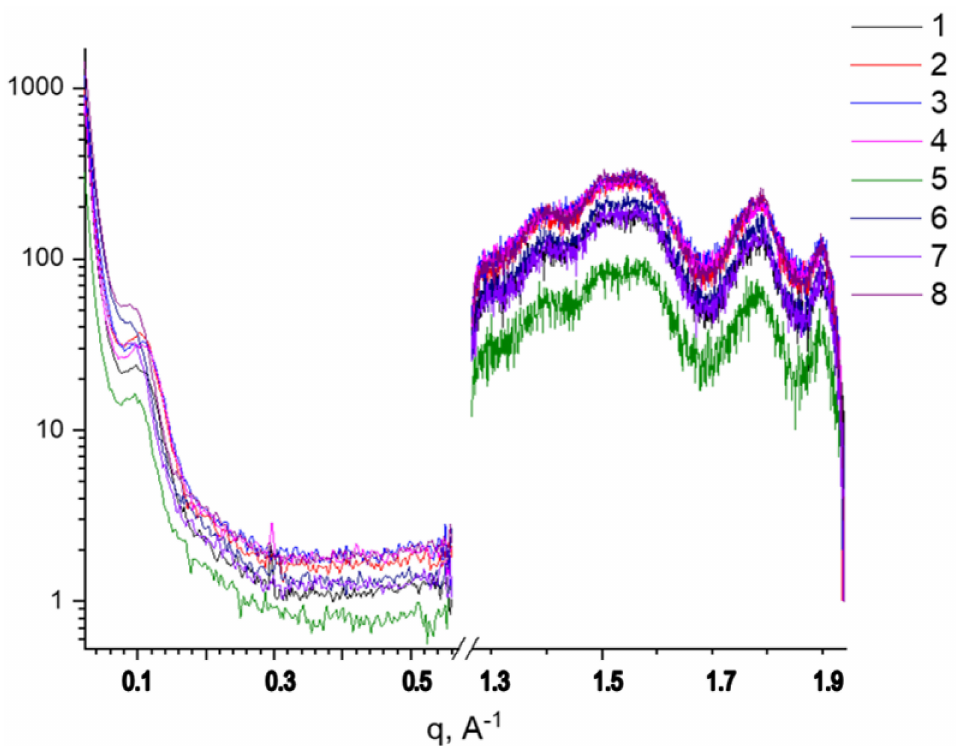
Figure 3. Diffractograms of PHB fibers containing metal-porphyrin complex (FeCl-TPP) before (1–4) and after annealing (5–8). PHB: nonannealed (1) and annealed (5); PHB-TPP-FeCl (1%): nonannealed (2) and annealed (6); PHB-TPP-FeCl (3%): nonannealed (3) and annealed (7); PHB-TPP-FeCl (5%): nonannealed (4) and annealed